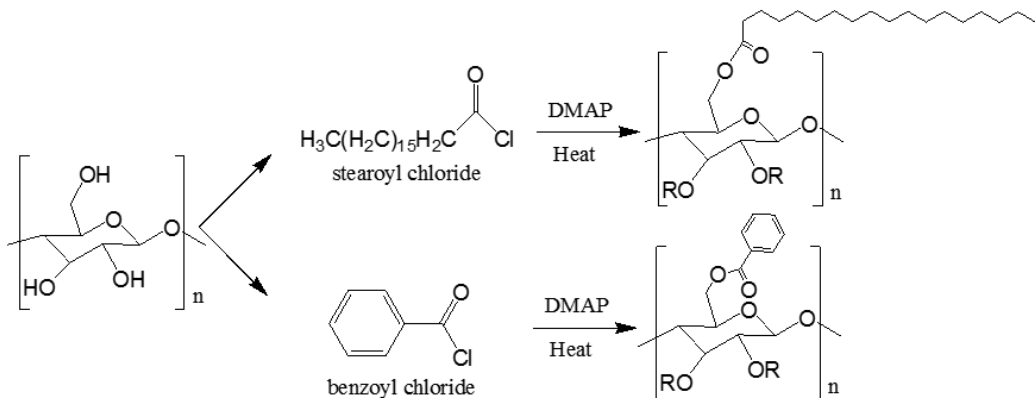
Figure 2. 1 H NMR spectrum ( a ) and 13 C NMR spectrum ( b ) of the St–Cell.